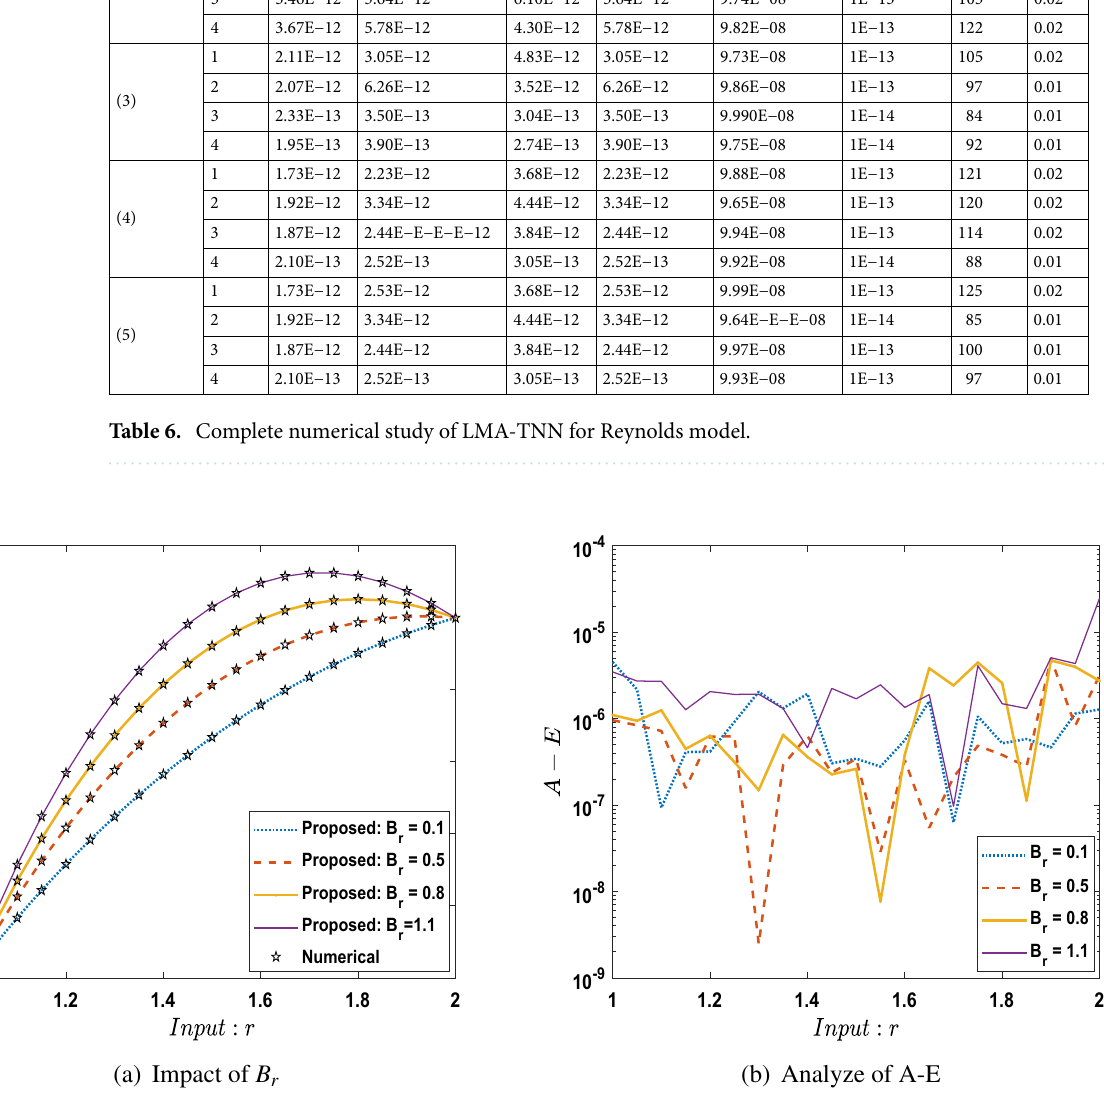
Figure 21. Comparison between LMA-TNN with results of numerical reference for scenario 1 in constant